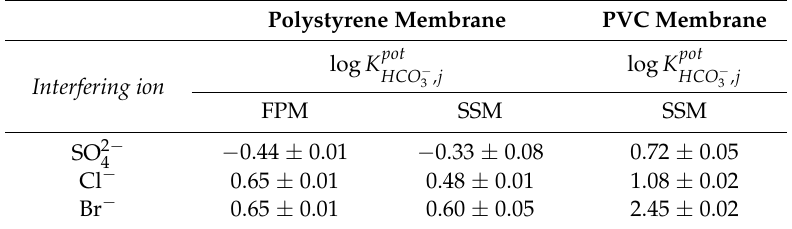
Table 2. Potentiometric selectivity coefficients determined by FPM and SSM method.